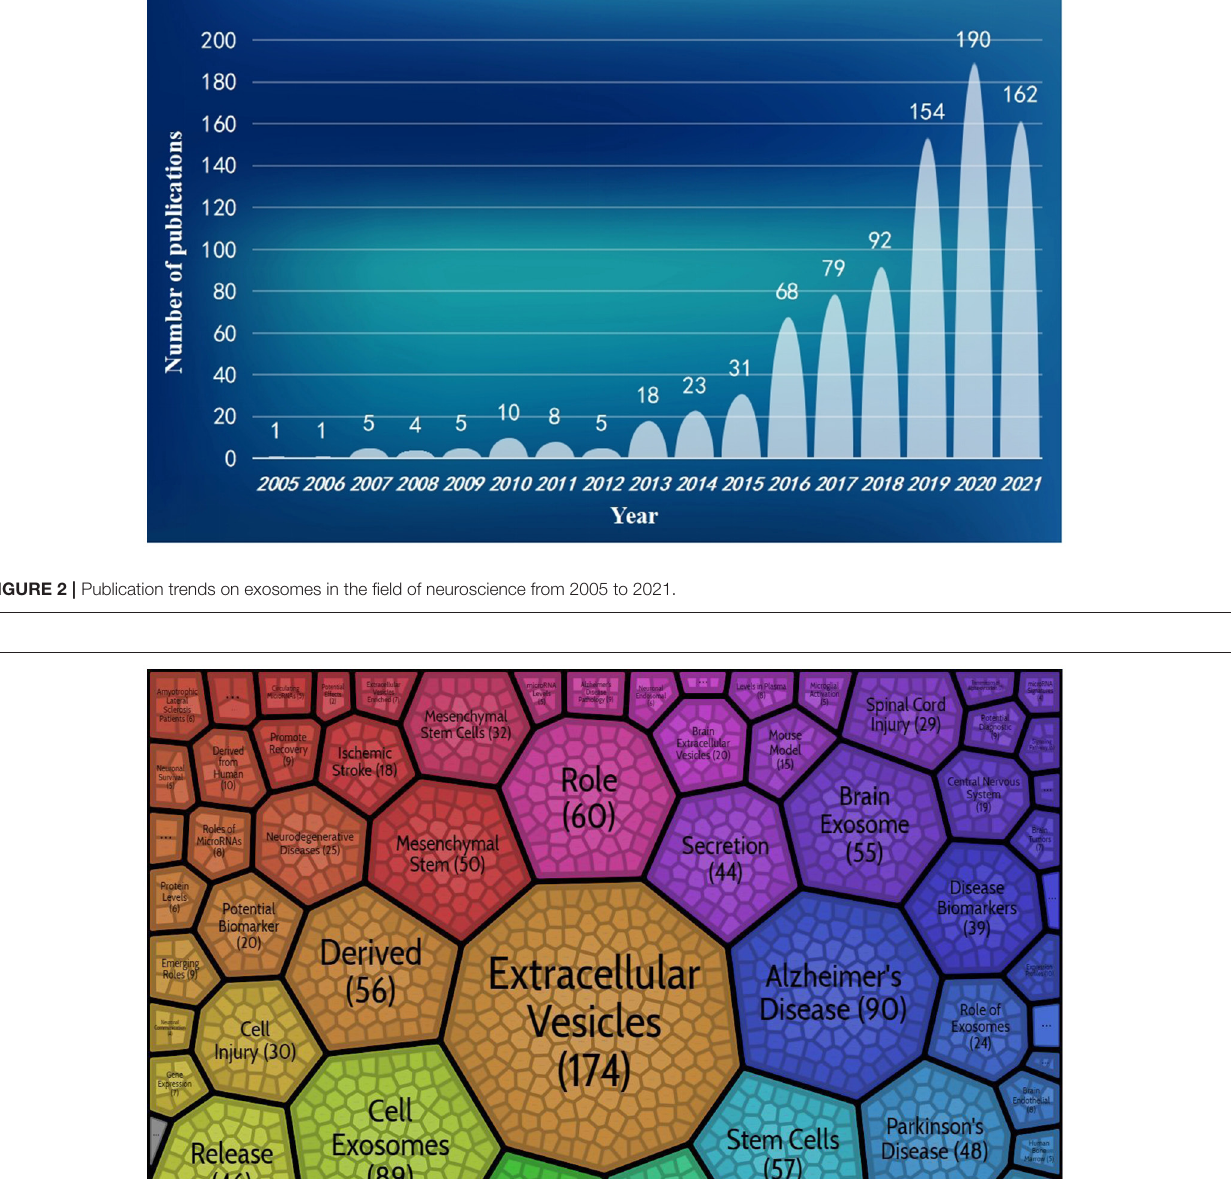
Based on the co-word matrix, a strategic diagram of 5 clusters was constructed ( Figure 6 ). The horizontal axis represented cluster centrality, and the vertical axis represented cluster